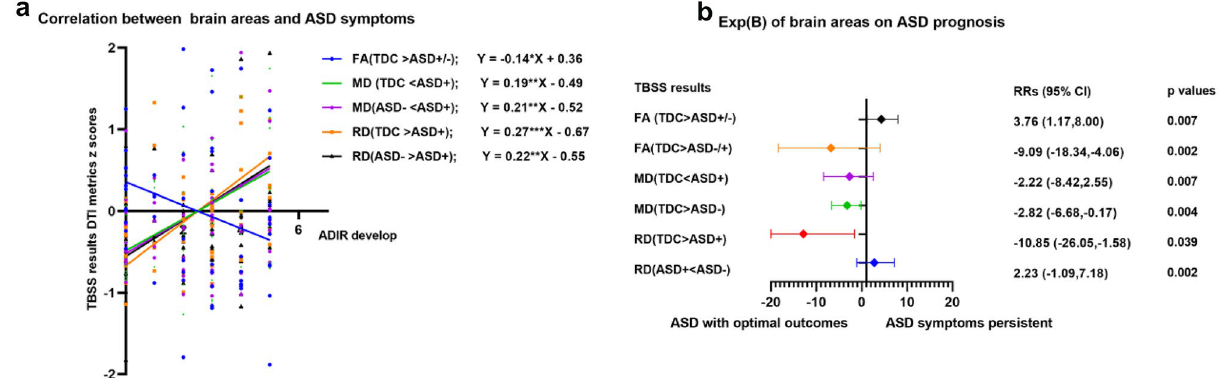
Figure 3. Brain-symptoms data analyses. *p < 0.05; **p < 0.01; ***p < 0.001. ( a ) Statistically significant correlations between dMRI metrics and ADI-R develop subscale. Dotted lines represent the r value for those correlations. ( b ) Forest plot of the multivariable regression analysis results.